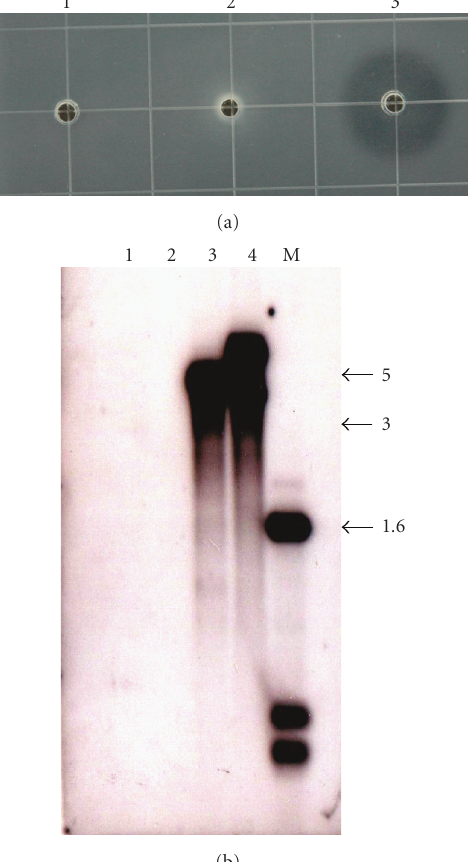
Figure 3: Panel (a) Hyaluronidase activity from spent media isolated from S. hyicus subsp. hyicus ATCC 11249 T (1), S. schleiferi subsp. coagulans ATCC 49545 T (2), and bovine testicular hyaluronidase (3). Panel (b) Southern analysis of Cla I-digested chromosomal DNA isolated from S. hyicus subsp. hyicus ATCC 11249 T (1), S. schleiferi subsp. coagulans ATCC 49545 T (2), S. aureus SH1000 (3), and Sanger-252 (4). M: marker